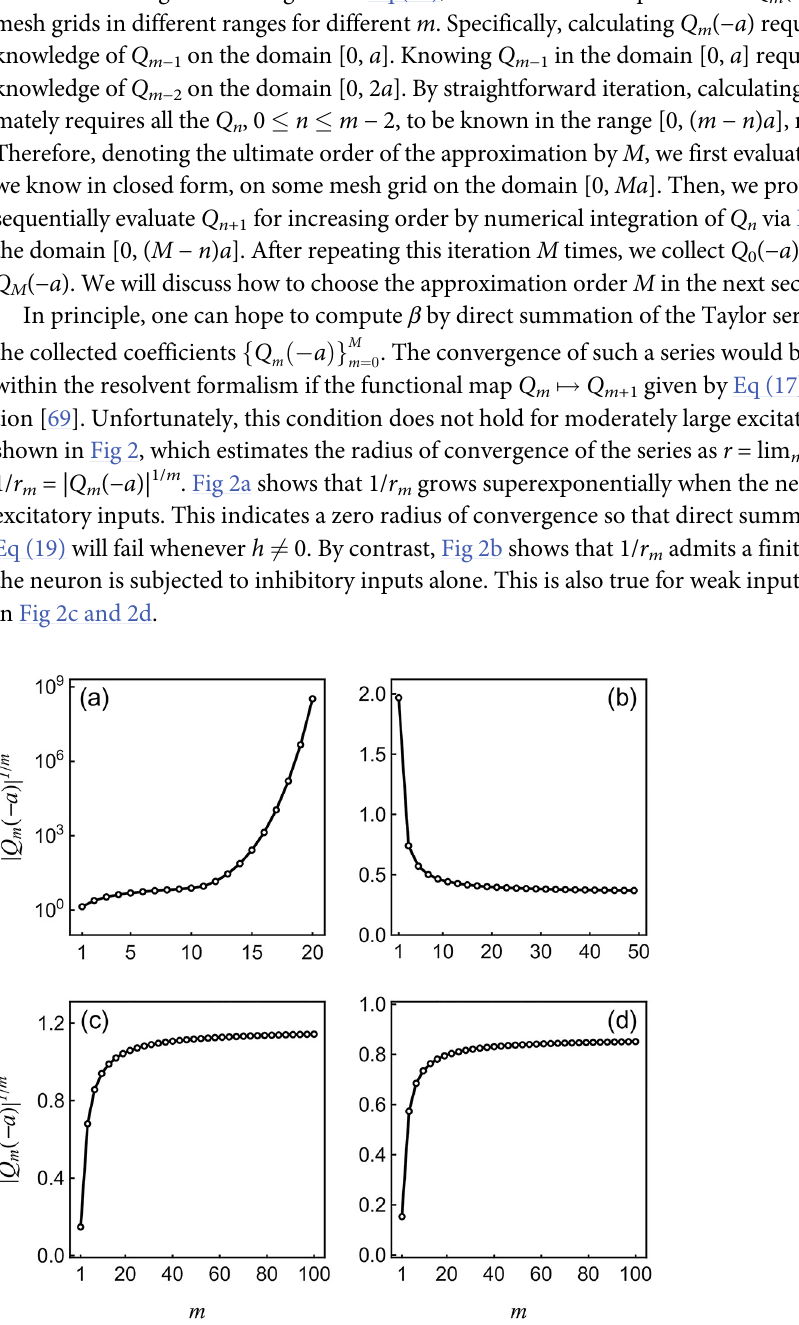
Fig 2. Plots of 1/ r = | Q ( − a )| 1/ m v.s. m . This figure shows the numerical values of the series coefficients subjected to m m different types of inputs. The input rates β = 0.5 kHz are the same across all four panels. In panel (a), the neuron is e , i subjected to an excitatory input with μ e = 3. The superexponential growth of 1/ r m is clearly manifested in this log-scale = − 3. In panel (c) and (d), the neuron is plot. In panel (b), the neuron is subjected to an inhibitory input with μ i subjected to a weak excitatory and inhibitory input with μ e = 0.3 and μ i = − 0.3 respectively. In these three cases, 1/ r m converges to finite values. Parameters: h = 1 Hz, a = 0.1, τ = 10